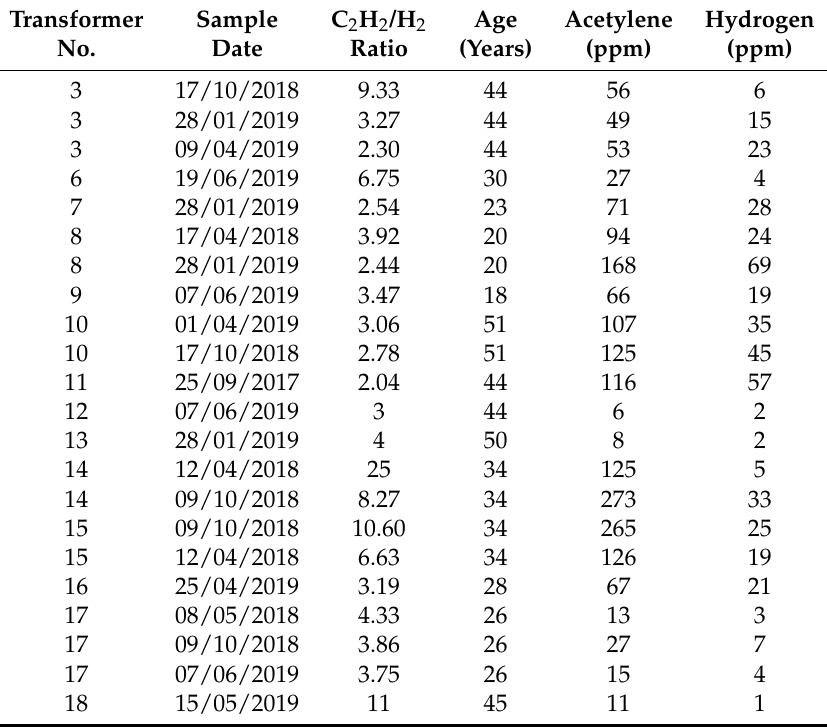
Table 5. Transformer data with the C 2 H 2 /H 2 ratio greater than